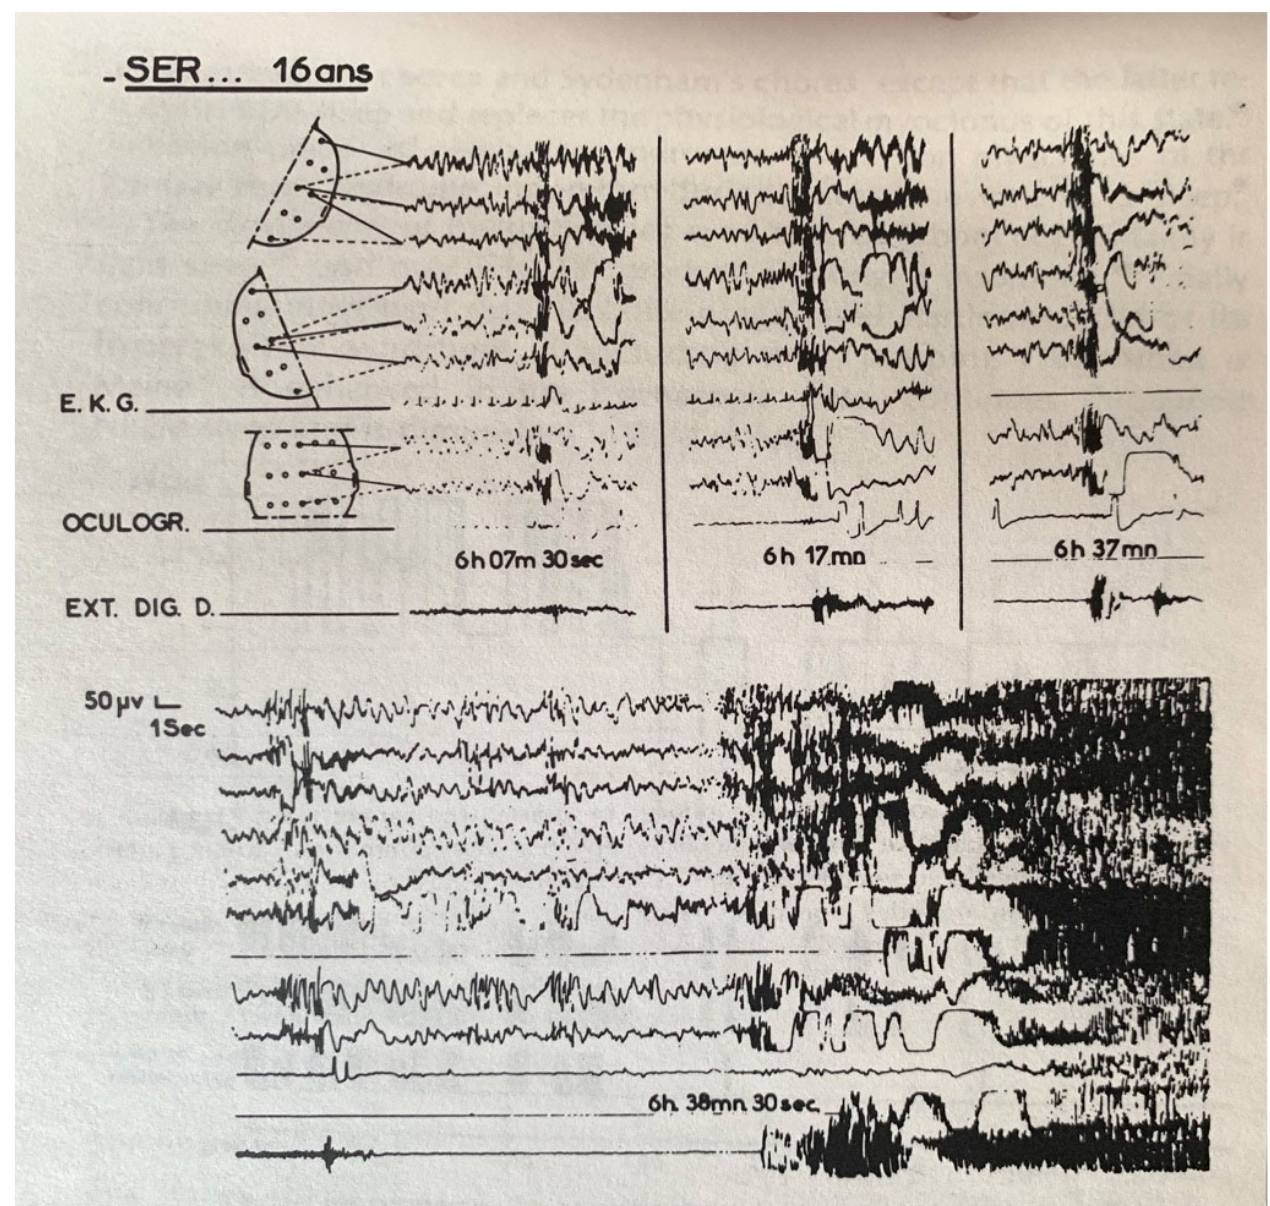
Figure 24. A generalized tonic ‐ clonic seizure induced by awakening. In the first segments selected there are polyspike and wave discharges, these increase in frequency and culminate in a generalized tonic clonic seizure at 6 h 38 min in the morning. (Adapted from Gastaut, H. and Broughton, R.: A clinical and polygraphic study of episodic phenomena during sleep. Academic Address, in: Wortis, J. (Ed.), Recent Advances in Biological Psychiatry, New York, Plenum Press, 1965, pp. 197–221).